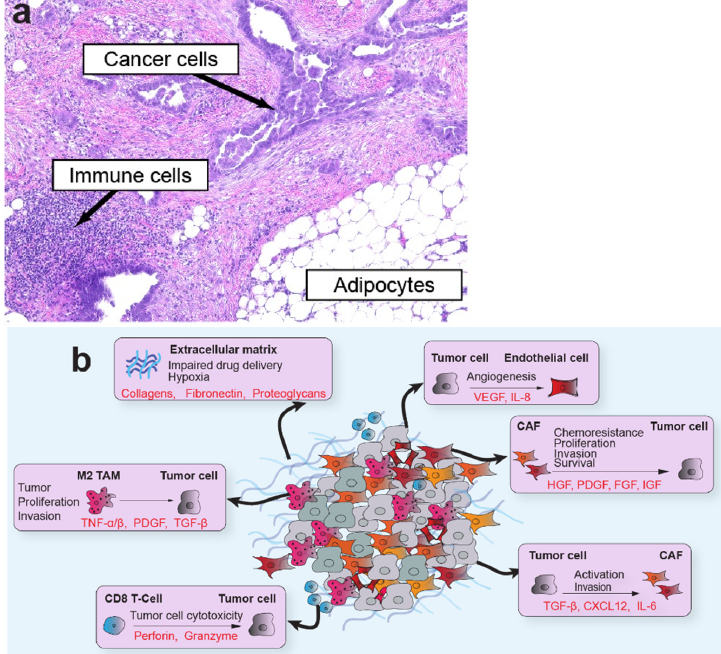
Figure 1. Cellular heterogeneity and bidirectional communication in the TME. ( a ) Representative image of a high-grade serous ovarian cancer metastasis to the omentum exemplifies the diverse ecosystem of tumors that includes cancer cells, immune cells, CAFs, adipocytes, endothelial cells, and other cells embedded in an ECM. CAFs and endothelial cells are present throughout the TME. (1:100) ( b ) Cross-talk between cell types in the ECM involves bidirectional signaling between tumor and stromal cell types that enforce a pro-tumorigenic